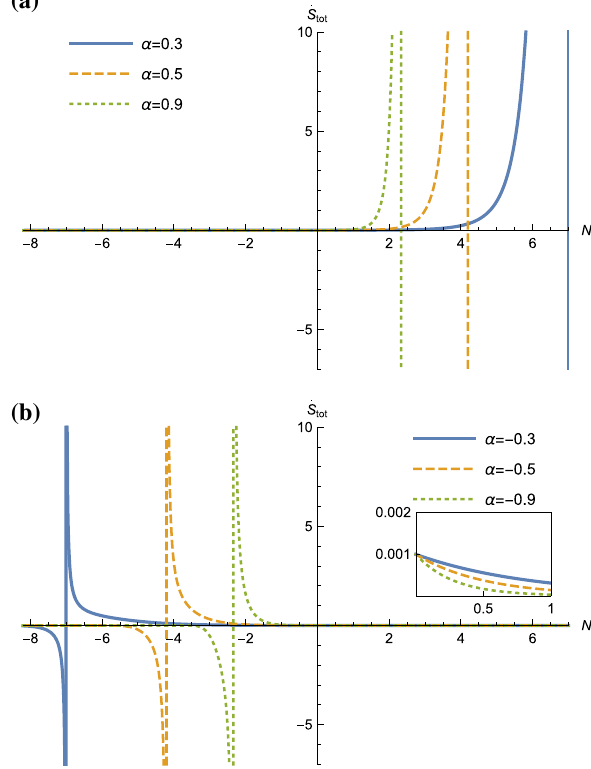
Fig. 2 ˙ S tot is plotted as a function of N . a in thawing scenario (for α = 0 . 3 , 0 . 5 and 0 . 9) b in freezing scenario (for α = − 0 . 3 , − 0 . 5 and − 0 . 9